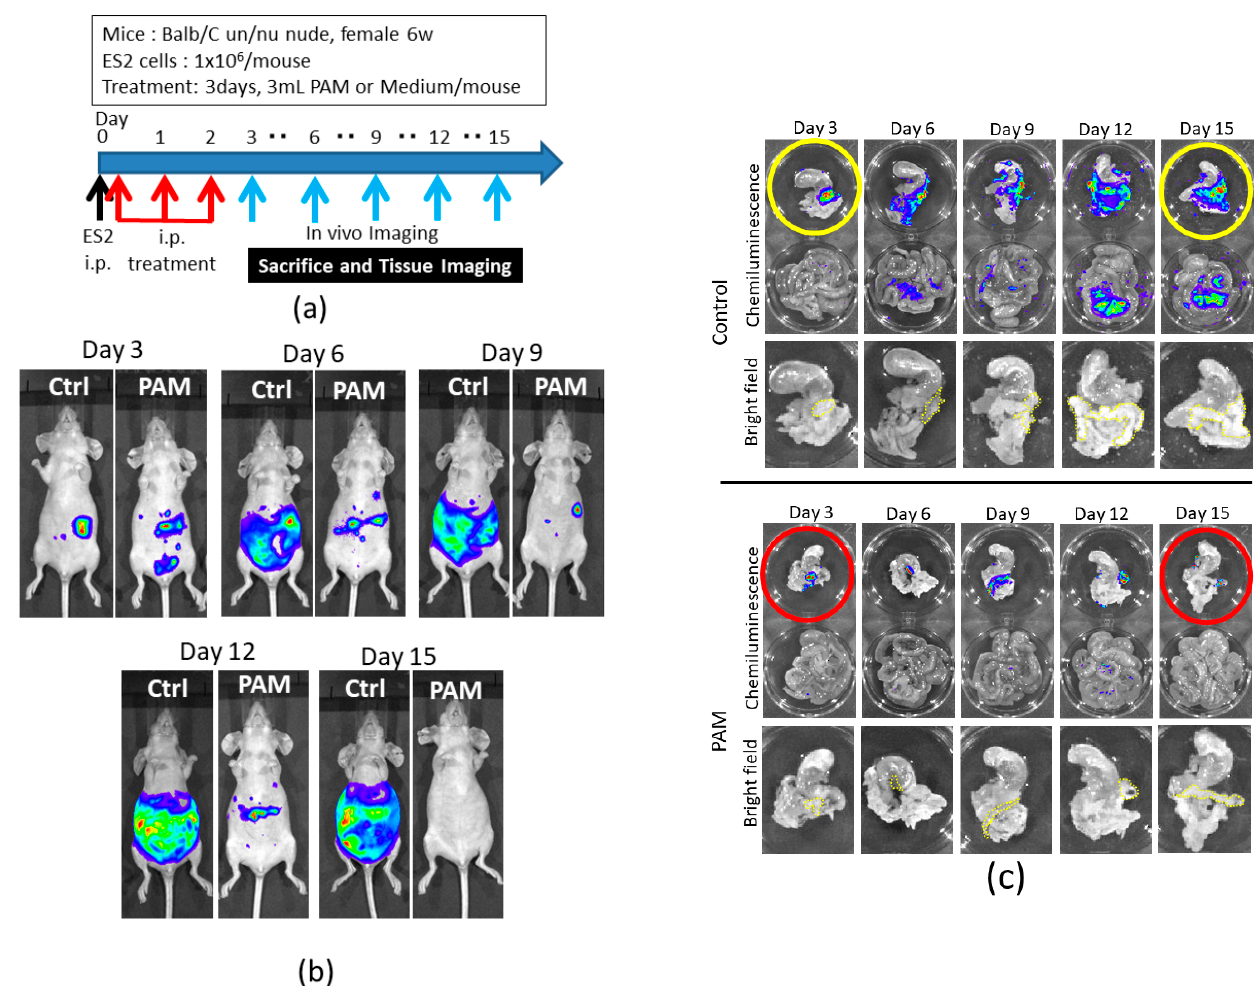
Figure 3. The antimetastatic effect of PAM in the ovarian cancer mouse model. ( a ) Outline of intraperitoneal PAM treatment in the model. ( b ) Peritoneal metastases in the PAM and control groups were evaluated every three days until day 15. ( c ) ES2 cells metastasized onto peritoneal tissues; omentum/pancreas with stomach were in the upper dish, mesenterium was in the lower dish, and their chemiluminescence was detected by the Xenogen IVIS 200 Imaging system. Yellow dashed lines in the bright field were indicated mouse omenta. The circled tissues were analyzed in the subsequent exper- iment.